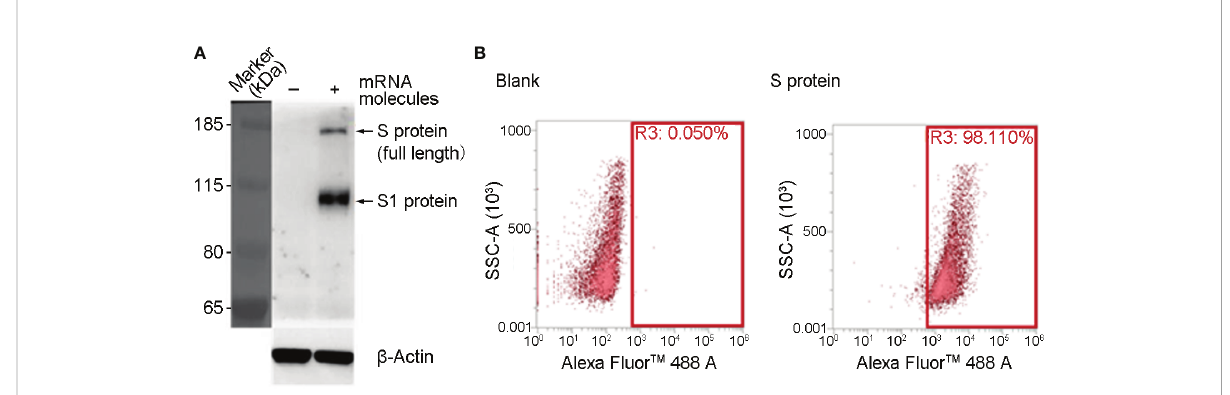
FIGURE 1 The expression of SYS600 mRNA molecule in 293T cells. 293T cells were transfected with mRNA molecules of SYS6006 for 24 hours. The expression of S protein was detected respectively by western blot (A) and FACS analysis (B)